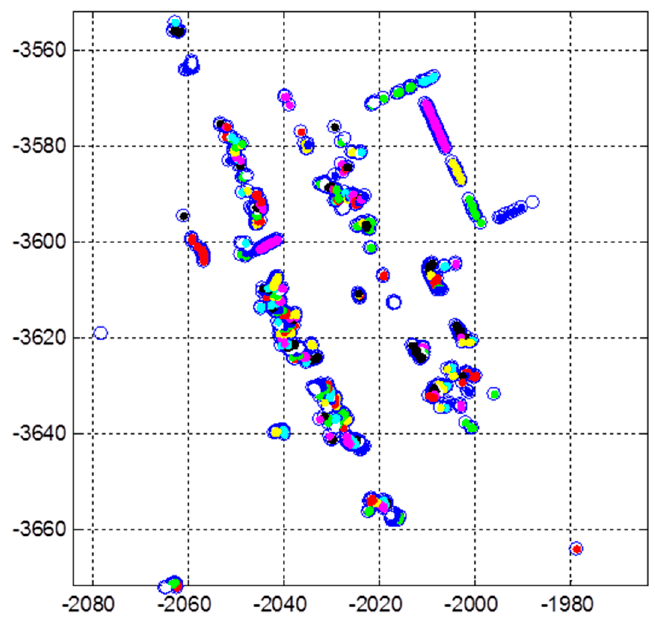
Figure 3. Line extraction result using the IEPF algorithm.